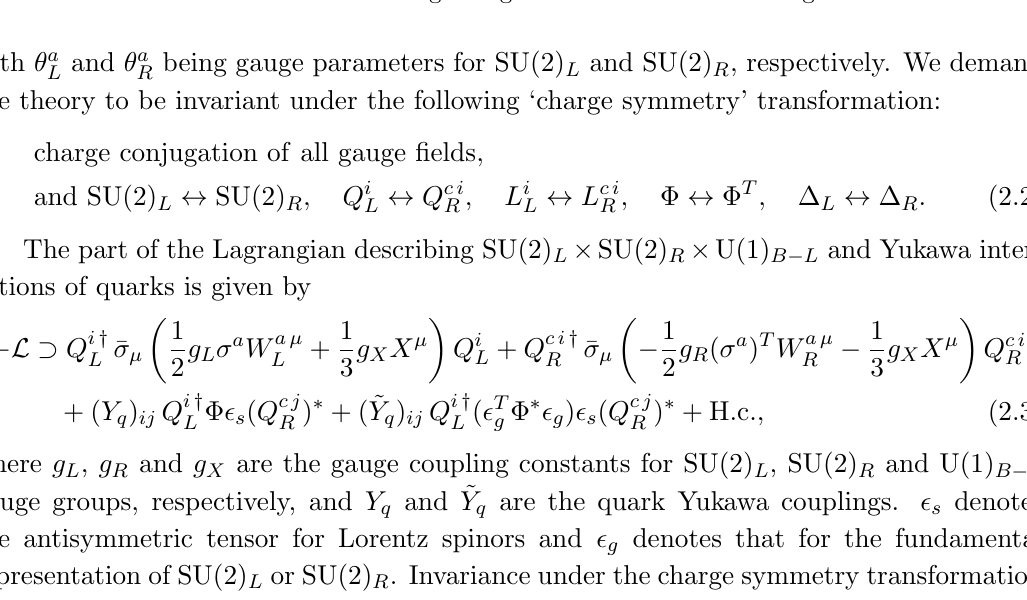
Table 1 . Field content and charge assignments. i labels the three